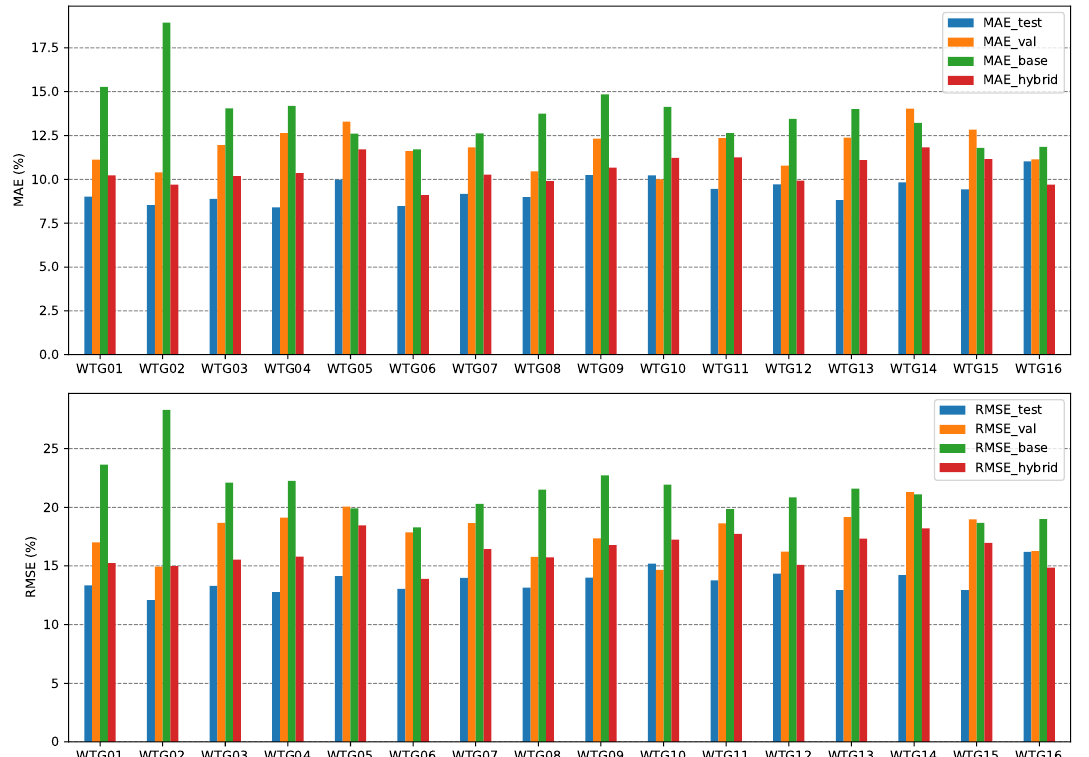
Figure 9. Normalized Mean Average Error and Root Mean Squared Error of the generated power predictions for each wind turbine. The predictions are obtained by the three models considered. The first is the direct power prediction using an ANN (including both test and validation results, in blue and orange respectively). The second is the validation set of the baseline model, in green. The third is the validation set of the hybrid model, depicted in red. It is worth mentioning that for the two last models it is not relevant to show the test set, because the baseline has no training and the test of the hybrid model has different units, since the ANN is trained to predict wind